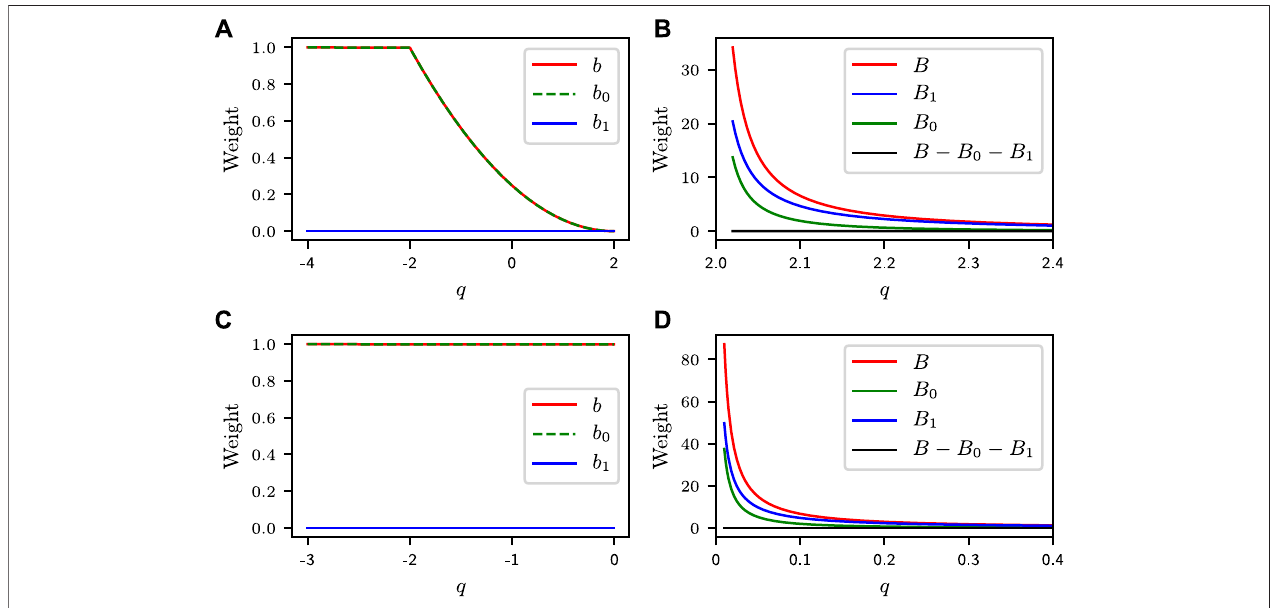
FIGURE 3 | Weights of ground-state twisted vector in the ground and low-lying excited states as functions of q at system size N = 10 000. The upper panel is for ferromagnetic interaction, where weights b i for q < 2 are shown in (A) , while weights B i for q > 2 are shown in (B) . The lower panel is for antiferromagnetic interaction, where weights b i for q < 0 are shown in (C) , while weights B i for q > 0 are shown in (D) .